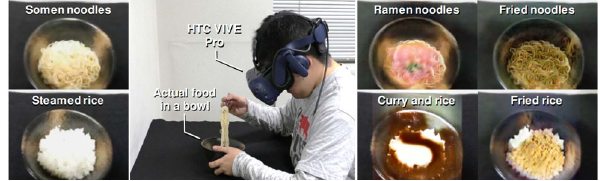
Fig. 14 GAN-based real-time food-to-food translation. Left: input food images. Center: user with an HMD experiencing gustatory manipulation. Right: translated food image examples. Reproduced with permission from Ref. [159], c (cid:2) Institute of Electrical and Electronics Engineers